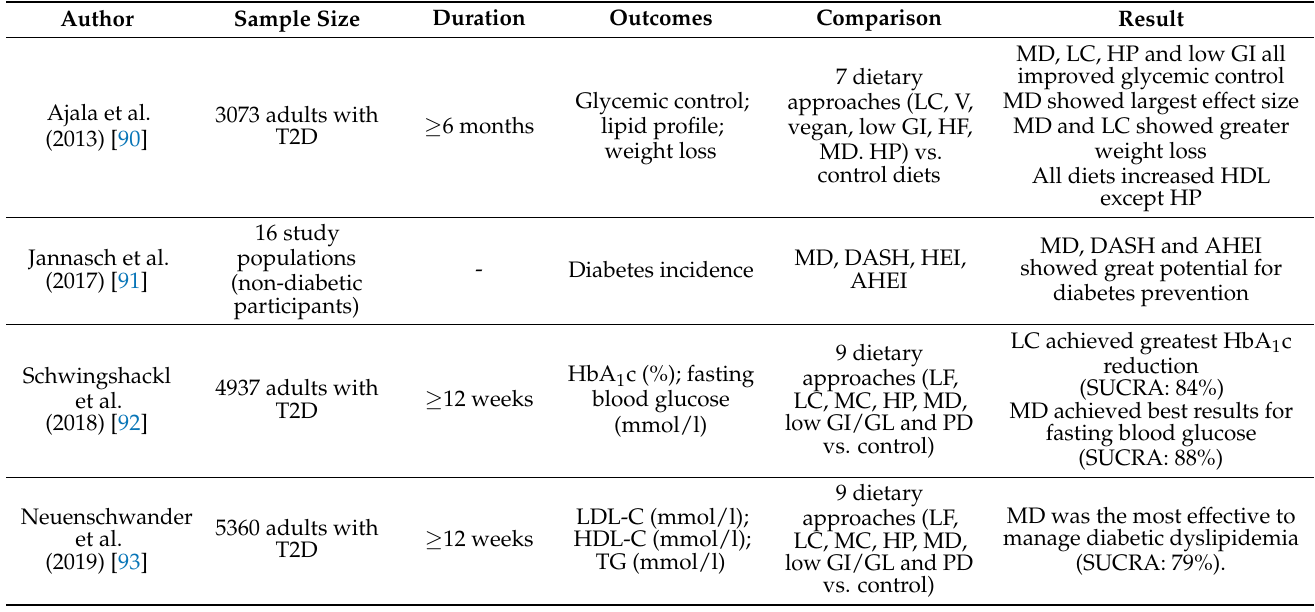
Table 1. Selected systematic reviews and meta-analyses comparing different dietary approaches in diabetes